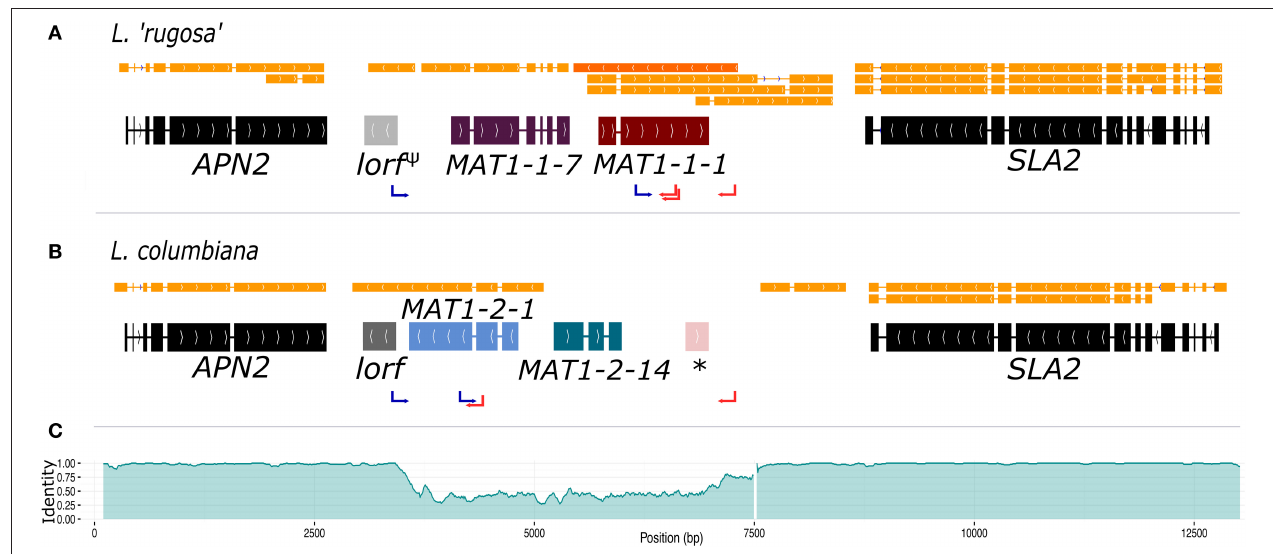
FIGURE 2 | The structure of the MAT idiomorphs in the genus Letharia . The typical gene content of the MAT1-1 idiomorph as exemplified by L. “rugosa” (A) is contrasted to the MAT1-2 idiomorph of L. columbiana (B) . The final gene models with intron-exon boundaries are shown along with the transcript models (orange). In (A) the antisense transcript of the MAT1-1-1 gene is marked with a darker orange color. Notice that the lorf gene is pseudogenized in L. “rugosa” ( lorf Ψ ). In (B) a star (*) shows the location of a sequence homologous, but highly divergent, to the last exon of the MAT1-1-1 gene. The pairwise identity between idiomorphs of the MAT locus is plotted in (C) using overlapping windows of 100 bp (incremental steps of 10 bp along the sequence), showing the drop in identity. The white gap toward the 3 ′ end of the area of low identity corresponds to a track of 129 bp in the MAT1-2 idiomorph of all species. The positions of forward (blue) and reverse (red) primers used for PCR screening are marked with